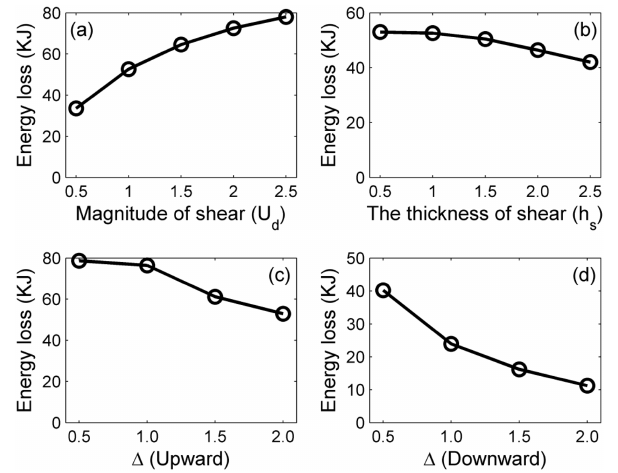
Figure 15. The summarized results of the energy loss of the mode- 2 ISW at 30 T with the presence of (a) varied magnitudes of shear currents, (b) varied thicknesses of shear currents, (c) upward off- set background shear currents and (d) downward offset background shear